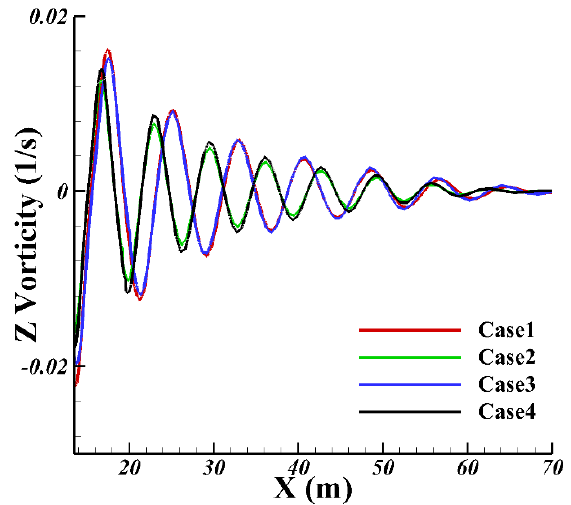
Figure 12. The Z vorticity distribution of the period time T = 0.425.